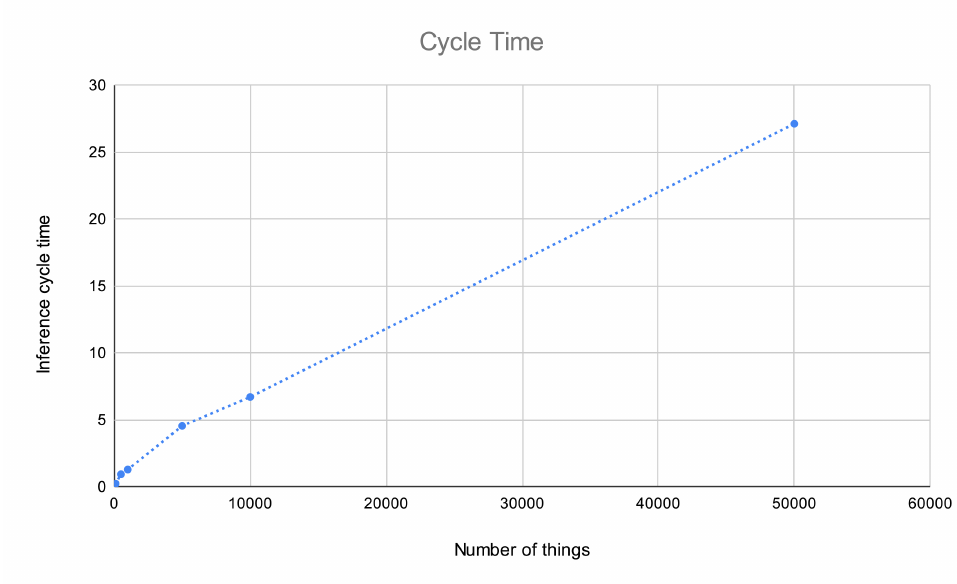
Figure 12. Correlation between inference cycle time and number of